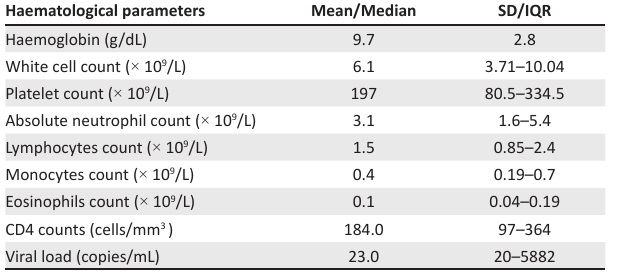
TABLE 4: Haematological parameters of the study population on presentation. Haematological parameters Mean/Median Haemoglobin